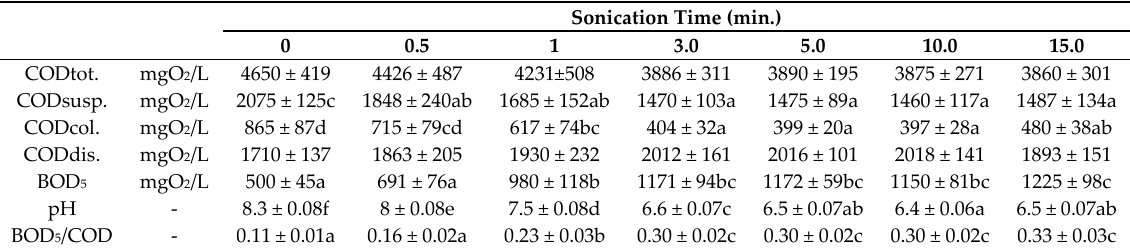
Table A2. Impact of sonication time on the biodegradability of organic compounds (with statistical analyses-letters denote different statistical